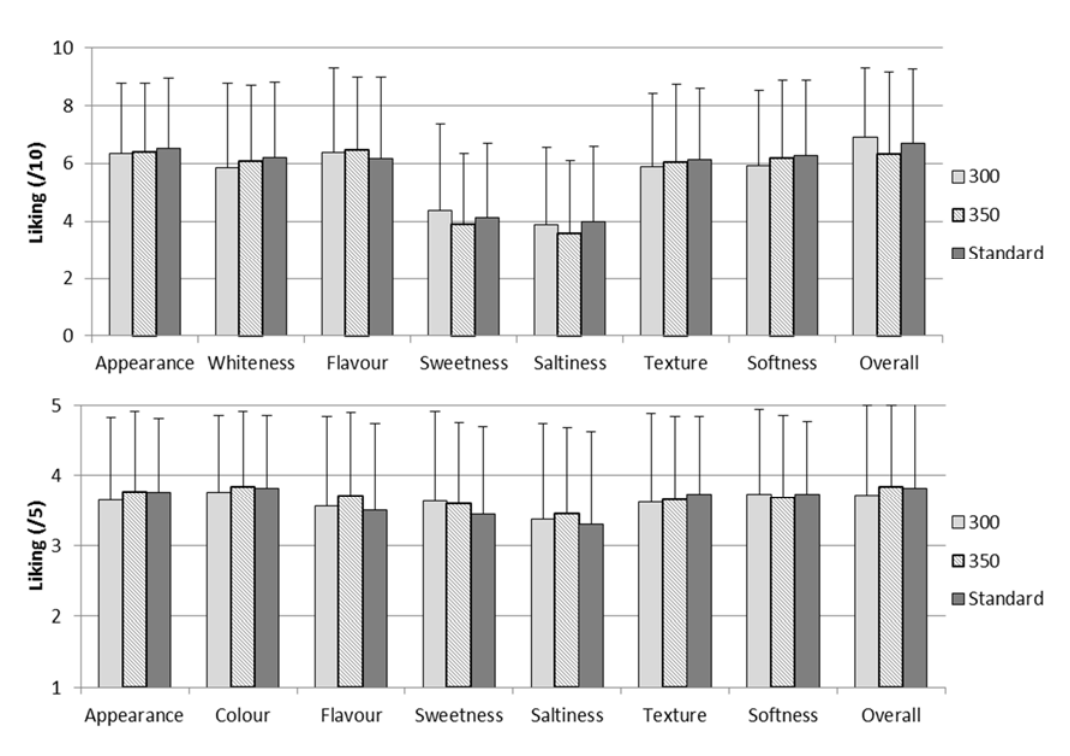
Figure 2. Average liking of Standard versus reduced sodium white ( A ) and wholemeal ( B ) breads. Error bars indicate standard deviation.